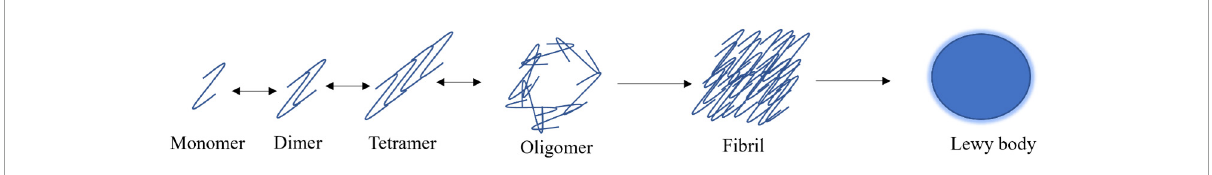
FIGURE2 α -synuclein aggregation model. α -synuclein exists as natively unfolded monomers that can reversibly form dimers, tetramers, and oligomeric species. α -synuclein has the propensity to aggregate irreversibly into β -rich fibrils which are the primary component of Lewy bodies.